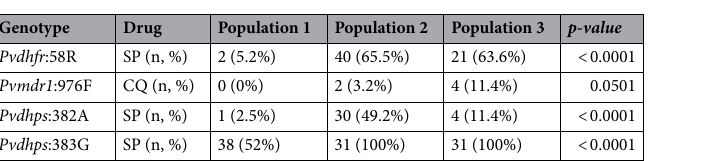
Table 2. Differences in prevalence of putative drug resistant SNPs among P. vivax